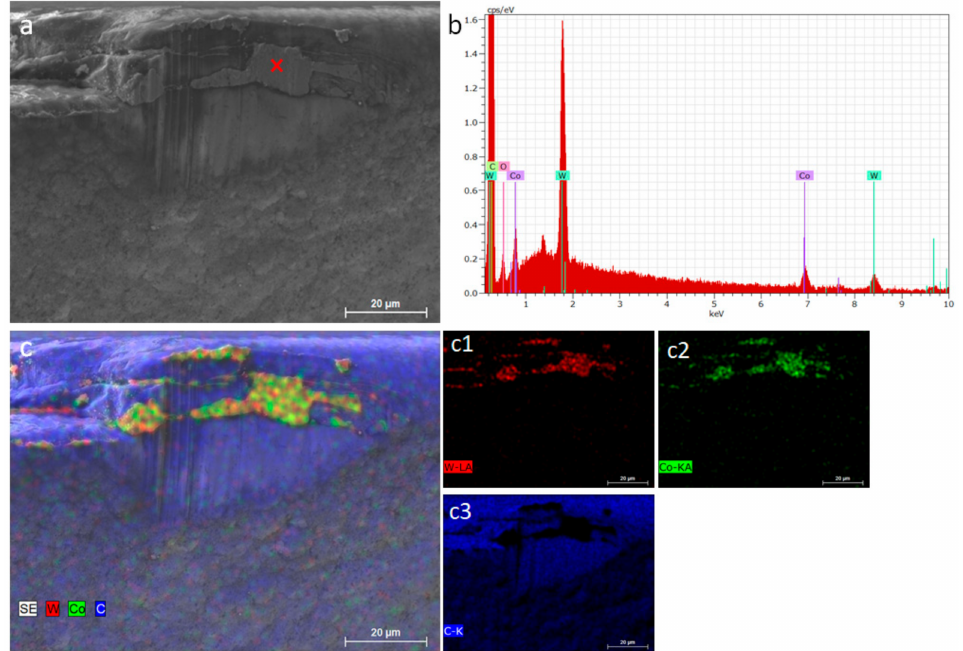
Figure 7. Wear characterization of the coating by energy dispersive X-ray spectroscopy (EDS) showing the spectrum ( b ) recorded from the red mark in ( a ). ( c ) The elemental mapping of image ( a ), along with individual maps (c1–c3), demonstrating adhesion of cemented carbide from the workpiece on the worn